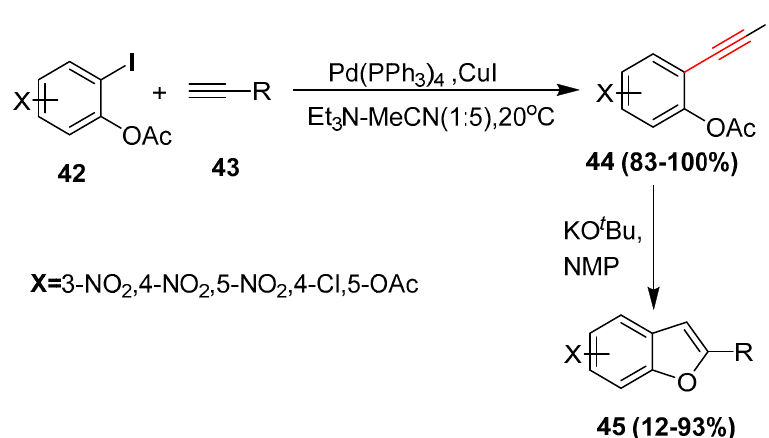
Scheme 8. Synthesis of Silylated Polystyrene. Scheme 8.